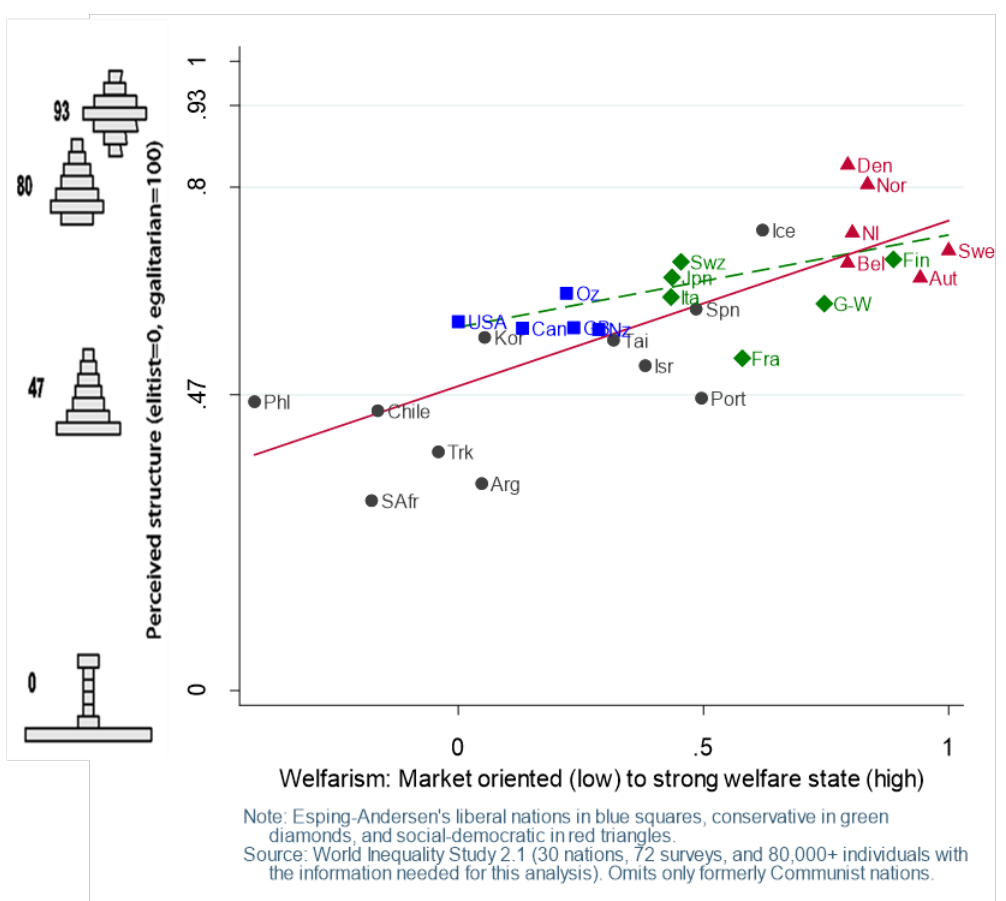
Figure 7. Perceptions of societal inequality. Country means and OLS fit lines (welfarism scale: solid red. Esping-Andersen: dashed green).